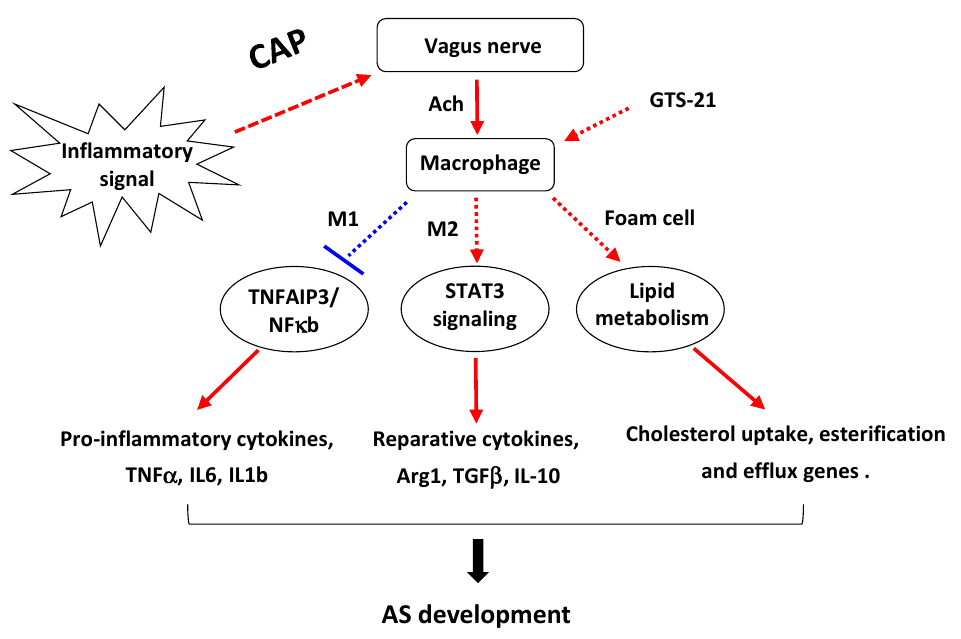
Figure 7. A schematic mechanism by which CAP regulates AS development. By receiving inflammatory signals, the vagus nerve can release neurotransmitter Ach to act on macrophages, leading to distinguished functions, i.e., the regulation of M1/M2 macrophage polarization and formation of foam cells, through coordinating their respective functional genes. CAP: cholinergic anti-inflammatory pathway; Ach: acetylcholine; AS: atherosclerosis.